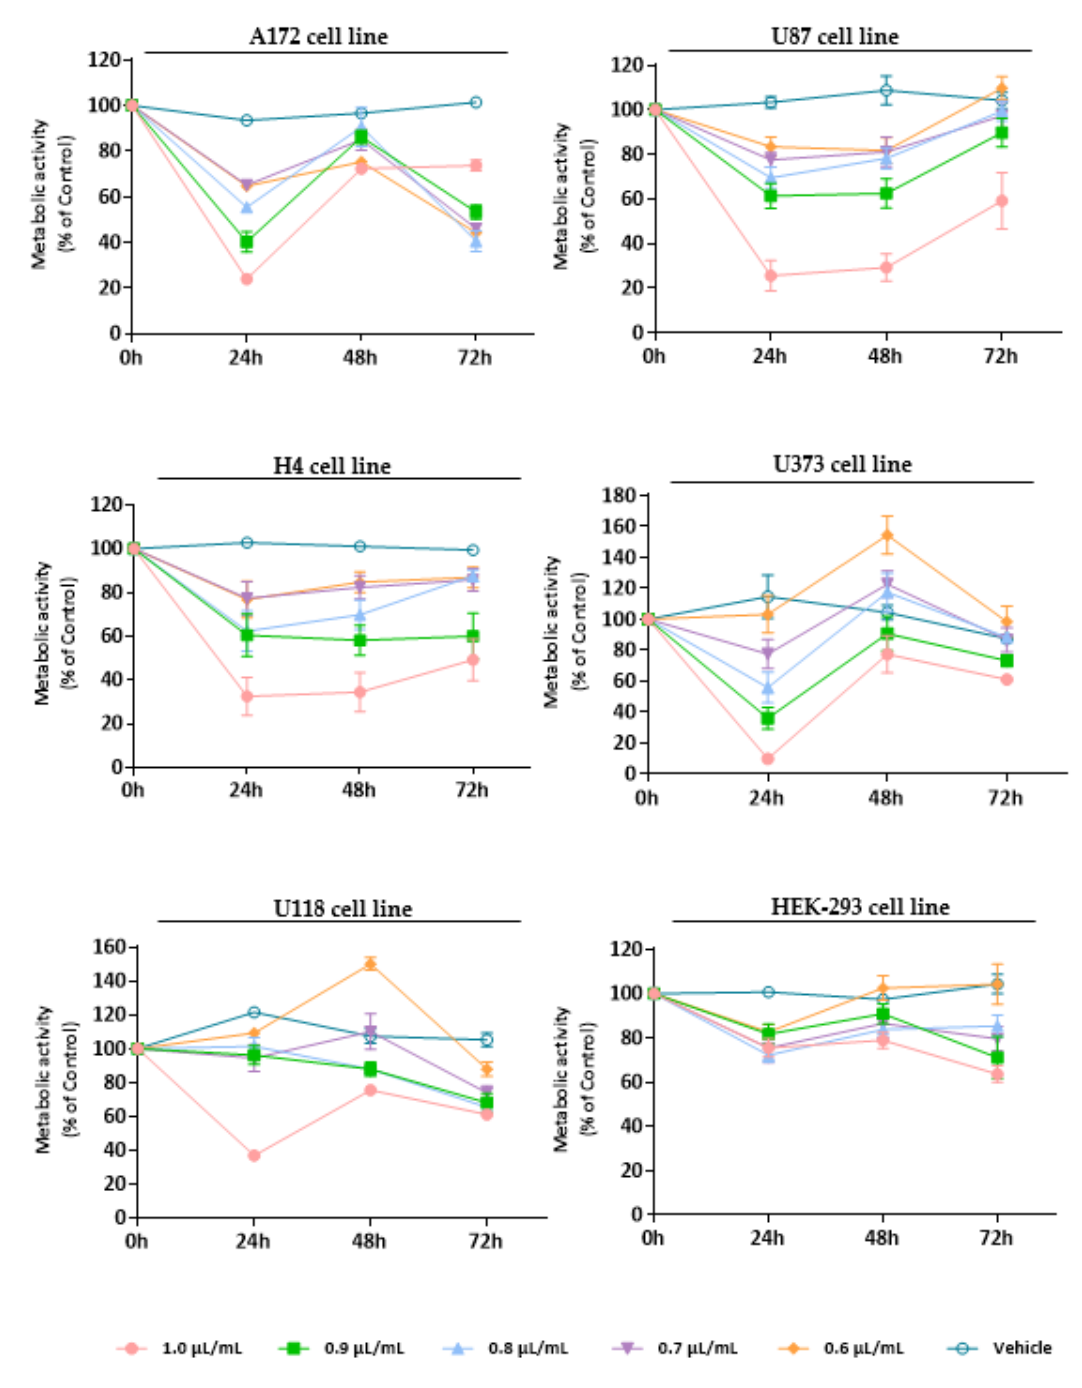
Figure 4. Cytotoxic effect of T. mastichina EO against GB cells (A172, U87, H4, U373, and U118 cell lines) and non-tumoral cells (HEK-293 cell line). Cells were treated either with T. mastichina EO (1.0, 0.9, 0.8, 0.7, and 0.6 µL/mL) or with the vehicle control (DMSO) for 24, 48, and 72 h. Cell viability (metabolic activity) was expressed as percentage of control (untreated cells). Results were presented as mean ± SD.